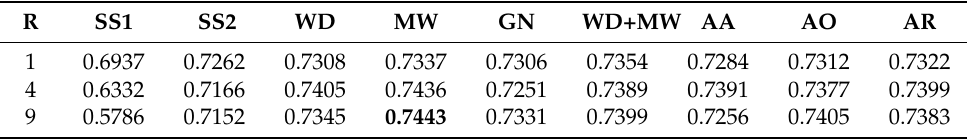
Table A6. Average accuracy of AtzoriNet* for each method at different augmentation ratios, R , for the Ninapro-DB1 dataset. The value in bold corresponds to the method with highest accuracy.